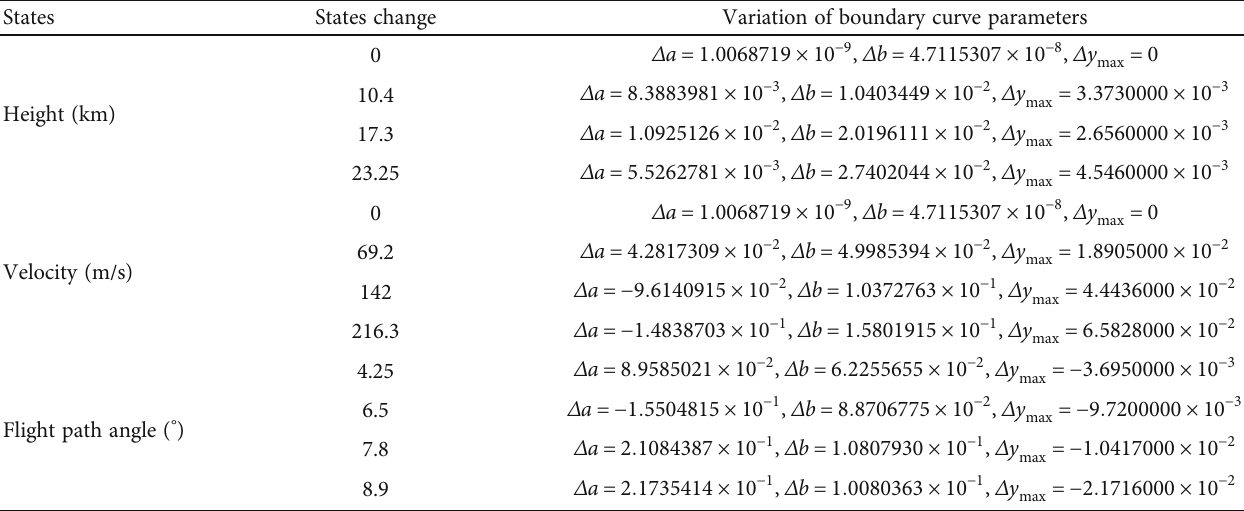
Figure 8: E ff ect of terminal states of the boost phase on the reachable area. Table 4: Relationship between boost terminal states and reachable area boundary parameters.